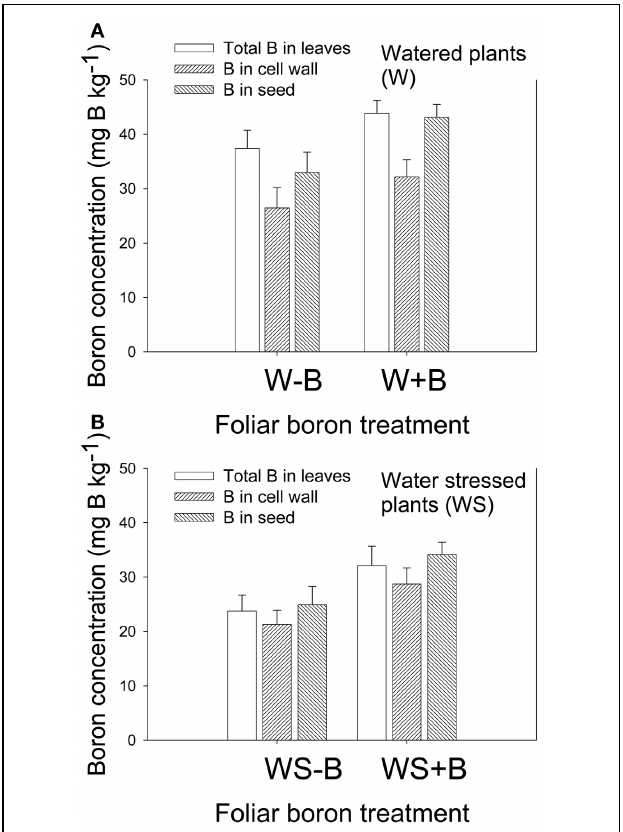
FIGURE 2 | Effect of foliar boron application (1.1kg ha − 1 ) on total and cell wall boron in leaves, and total boron in seed in watered plants (A) and water stressed plants (B). Treatments were watered plants without foliar B (W–B), and watered plants with foliar B (W +